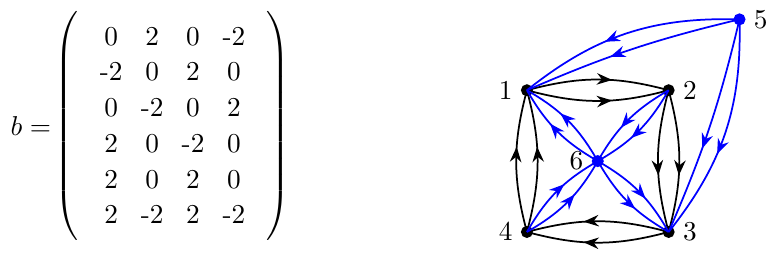
Figure 16 . Left: extended exchange matrix b for d SL 2 Toda chain. Right: extended quiver with frozen vertices shown by blue.